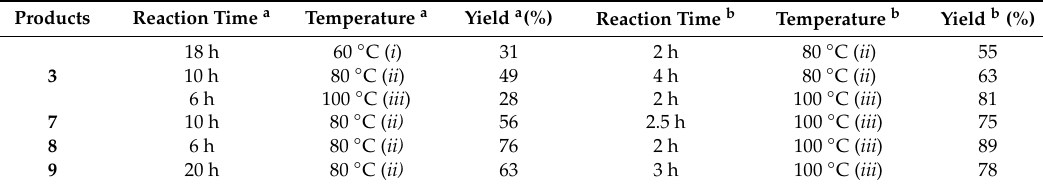
Table 1. Reaction conditions for the synthesis of the azaindole compounds 3 and 7 –